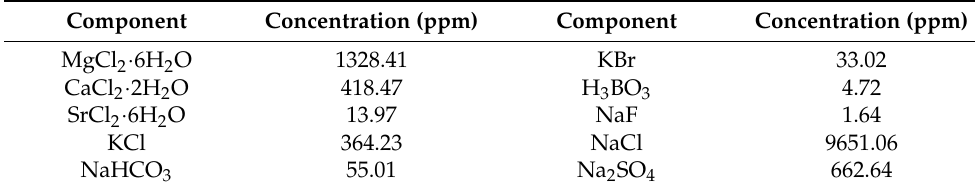
Table 1. Main components of the artificial seawater used in this